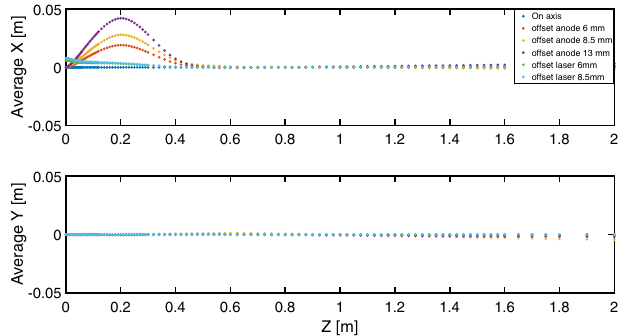
FIG. 10. Trajectory of the bunch center in the X and Y direction along the beam line.